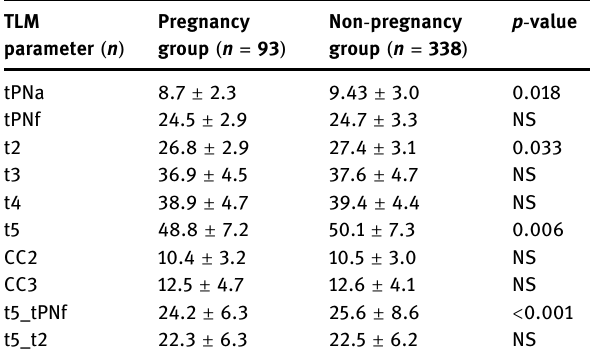
Table 3: Comparison of time - lapse